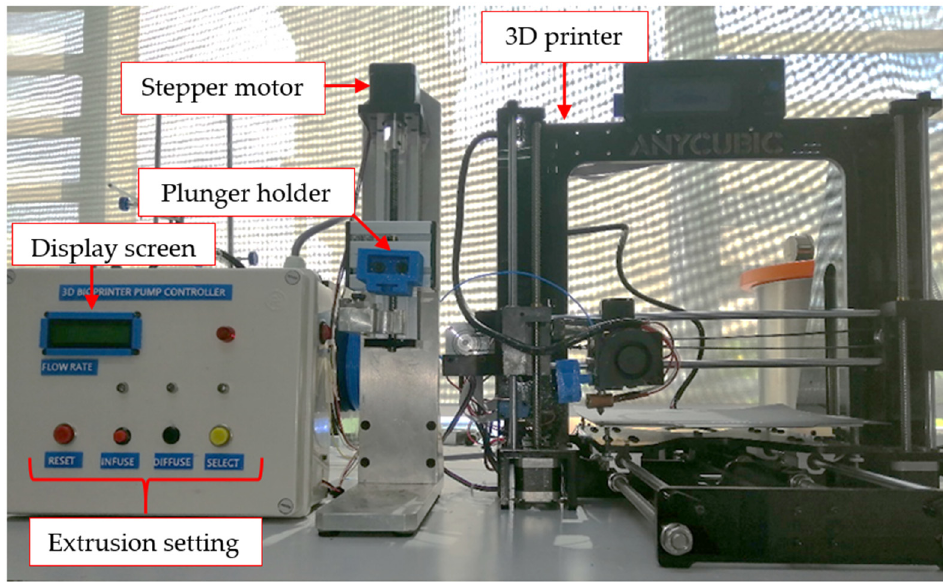
Figure 2. The 3D microextrusion-based bioprinting system used in the bioinks printability test.